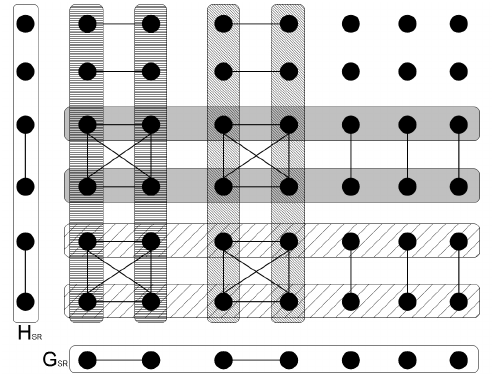
Fig. 1. Sketch of a representation of a strong resolving graph .G (cid:2) H/ SR